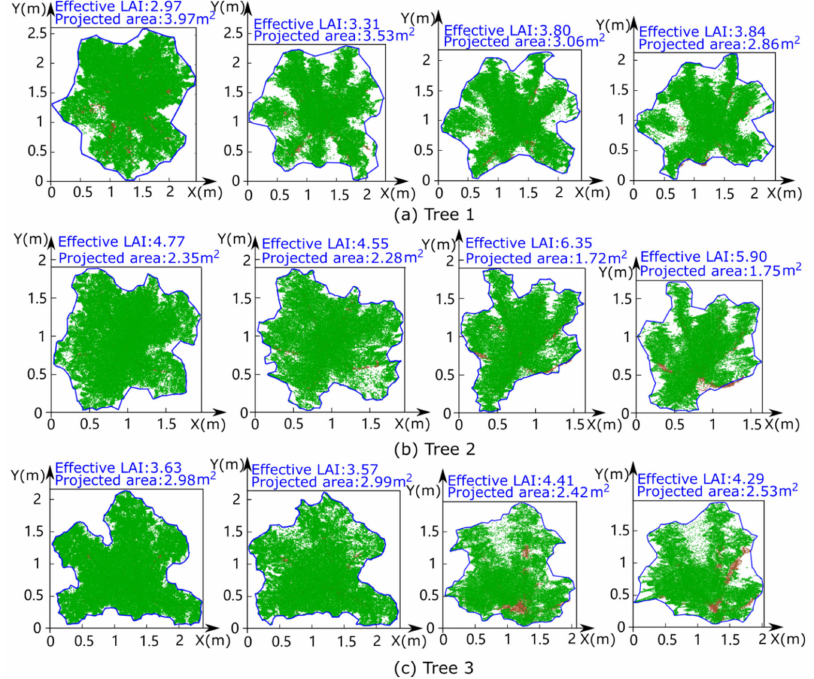
Figure 10. The vertical projection area of each rubber tree crown under various wind hazards. ( a – c ) represent Tree 1 (closest to the fan), Tree 2 (the middle tree), and Tree 3 (farthest from the fan), respectively, and the yellow circle represents the corresponding position of the forced draft fan in the current view. The columns from left to right represent the variations of windward area corresponding to different wind velocities, i.e., 4.6 m/s, 10.5 m/s, 13.5 m/s, and 17.5 m/s,